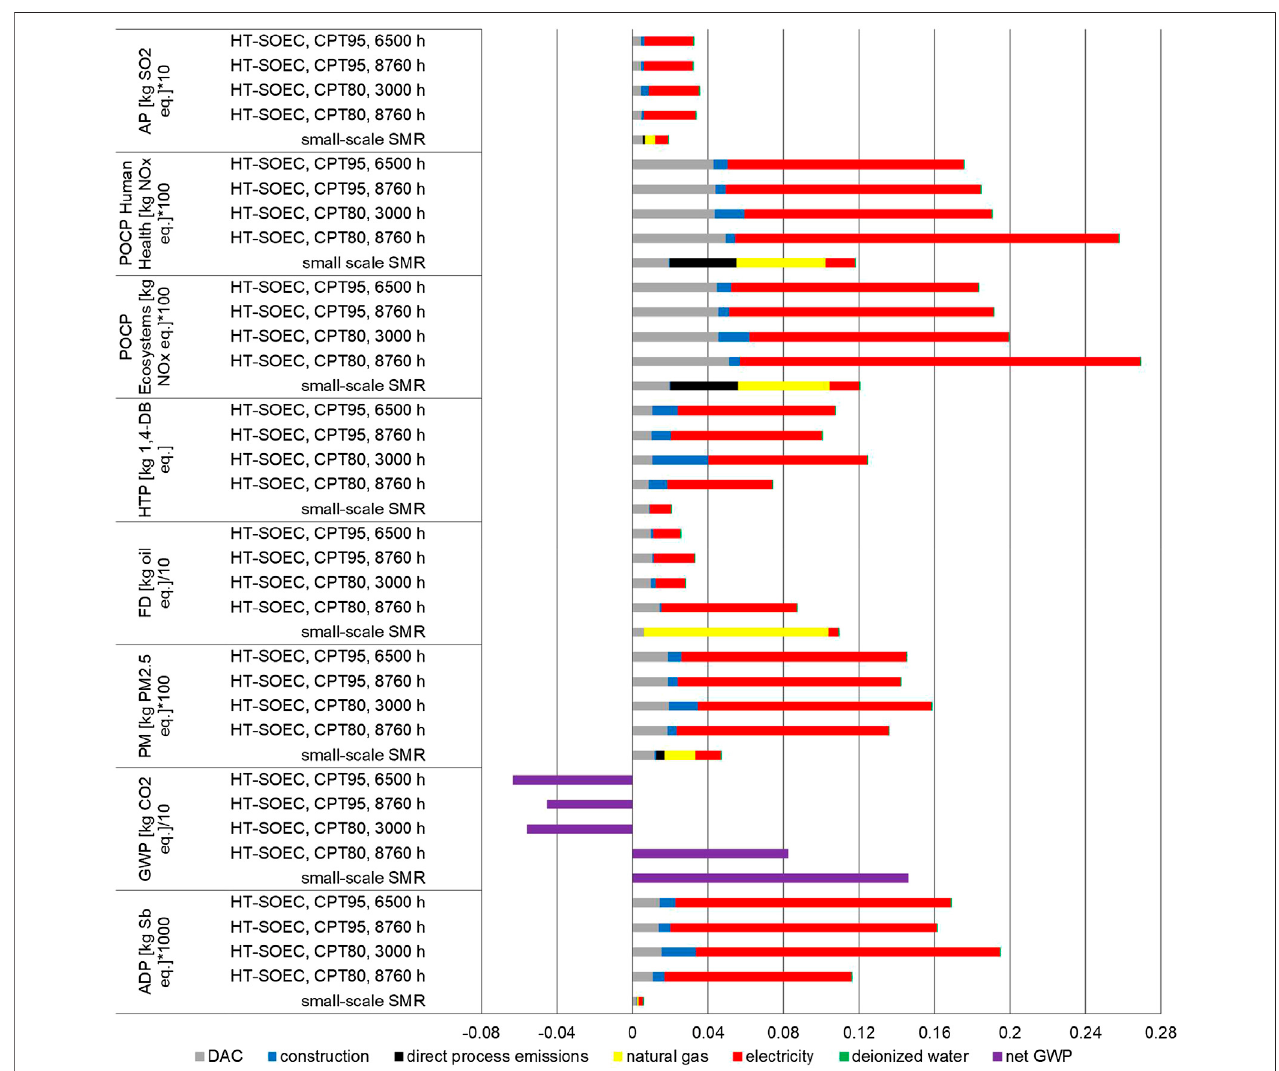
FIGURE 4 | Environmental impacts of small-scale SMR and HT-co-electrolysis for 1 kg of syngas (molar ratio H 2 /CO (cid:1) 2).